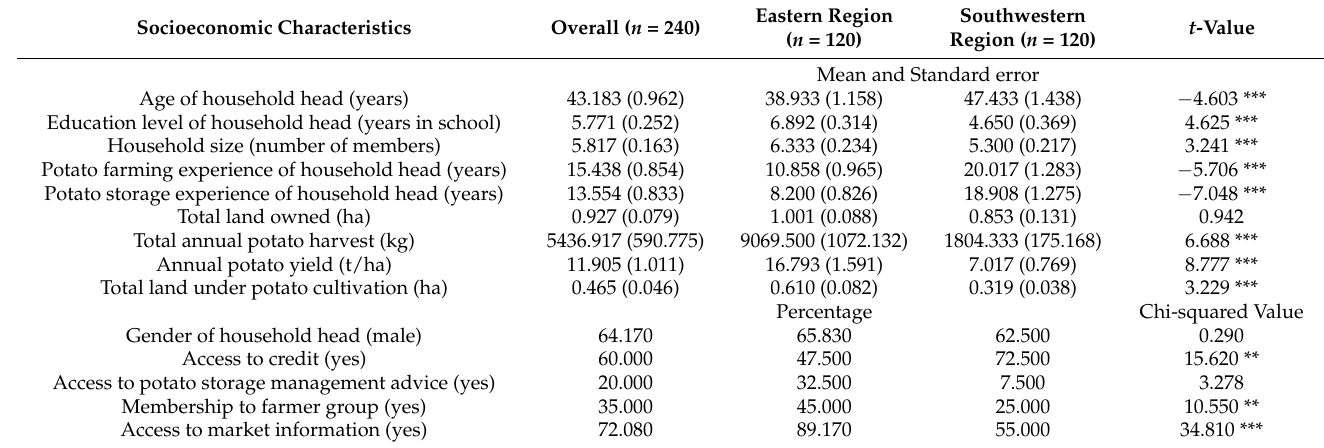
Table 3. Socioeconomic characteristics of the sampled potato